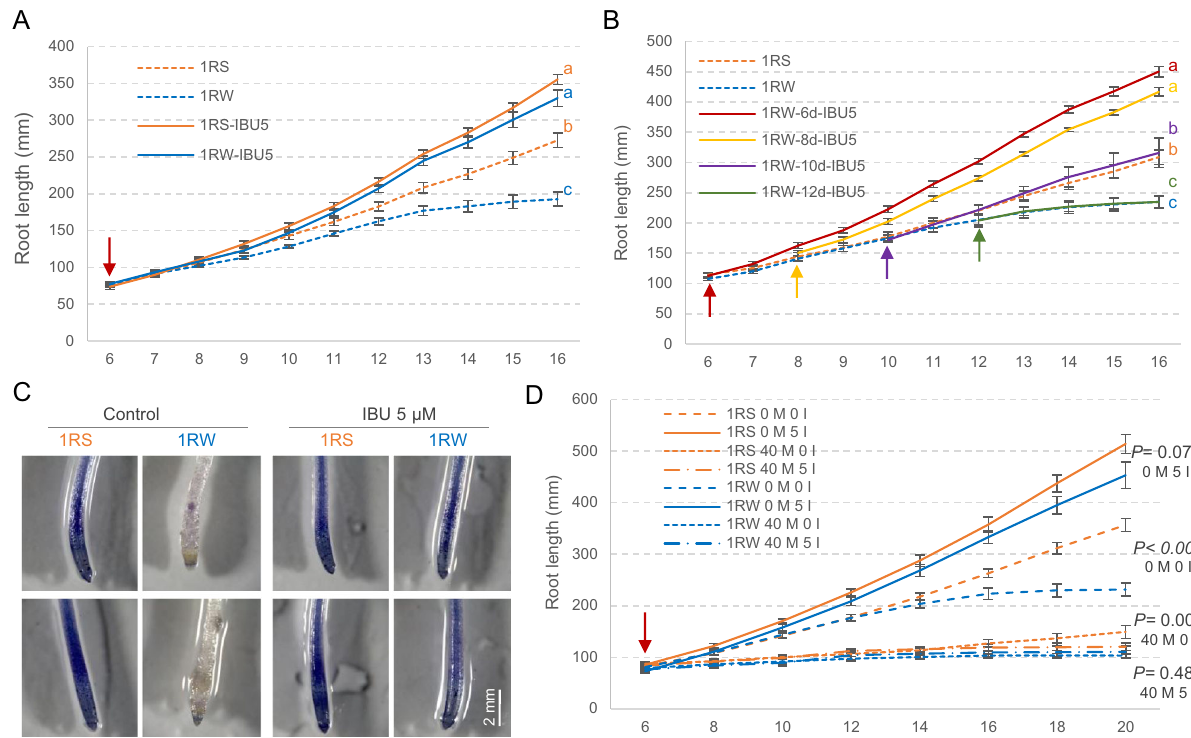
Fig.5|EffectofIbuprofen(IBU)onrootgrowth.A Averagerootlengthof1RSand 1RW ( n =9 – 10) with and without 5 μ M-IBU added at day 6 (red arrow). B Effect of 5 μ M-IBU added at 6, 8, 10, and 12 DAG (arrows) on 1RW root length ( n =8). A , B Different letters indicate signi fi cant differences at16 DAGbased on two-sided Tukey tests ( P <0.05). C Effect of 5 μ M-IBU on ROS distribution along roots